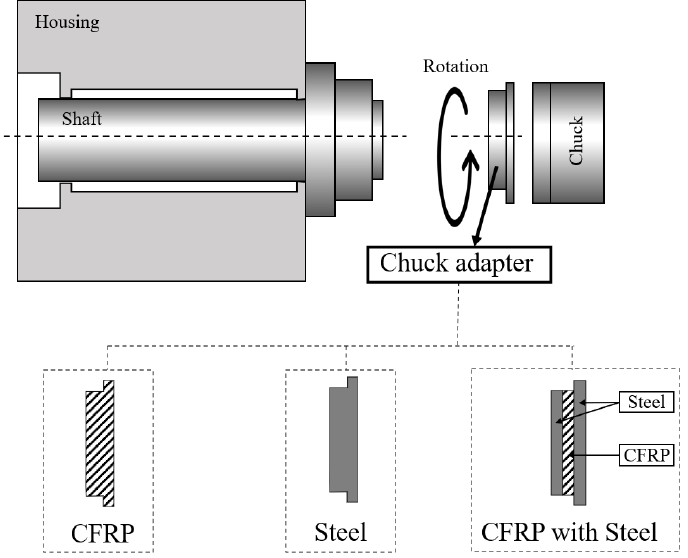
Figure 1. Schematic illustration of vibration experiment for different chuck adapters (CFRP, steel, and CFRP with steel).